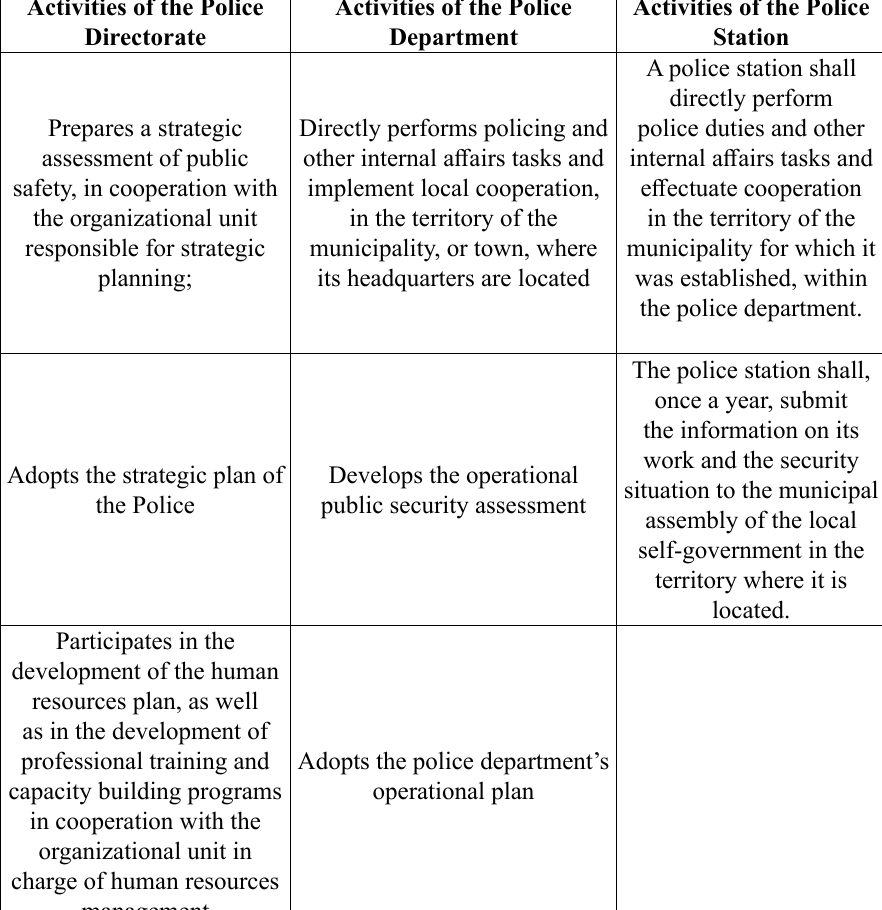
Table 1. Activities of the Police Directorate, Police Department, and Police Station Activities of the Police